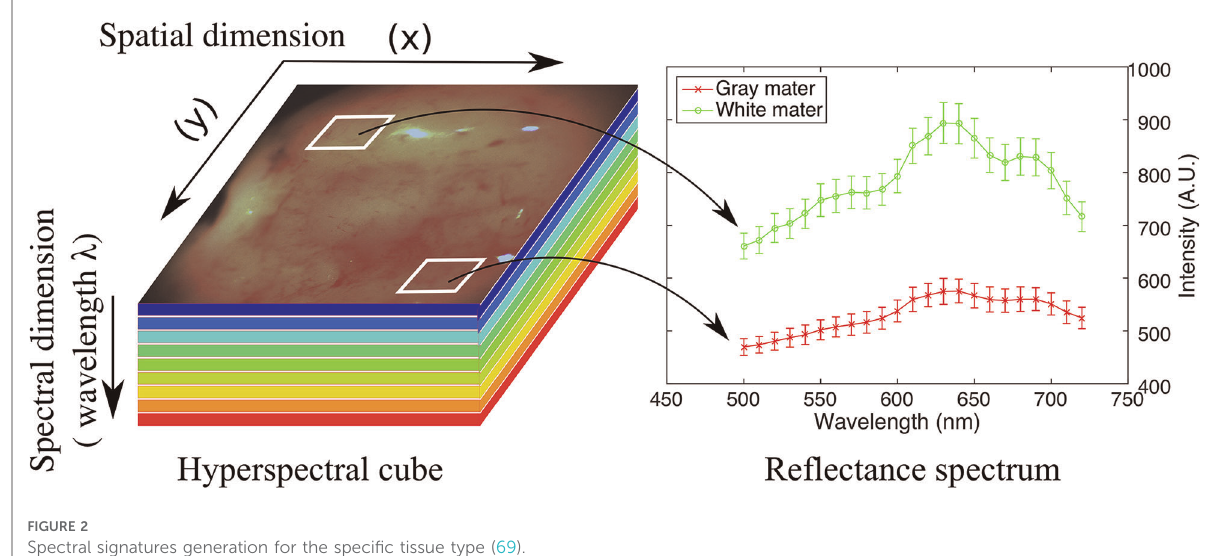
FIGURE 2 Spectral signatures generation for the speci fi c tissue type (69).